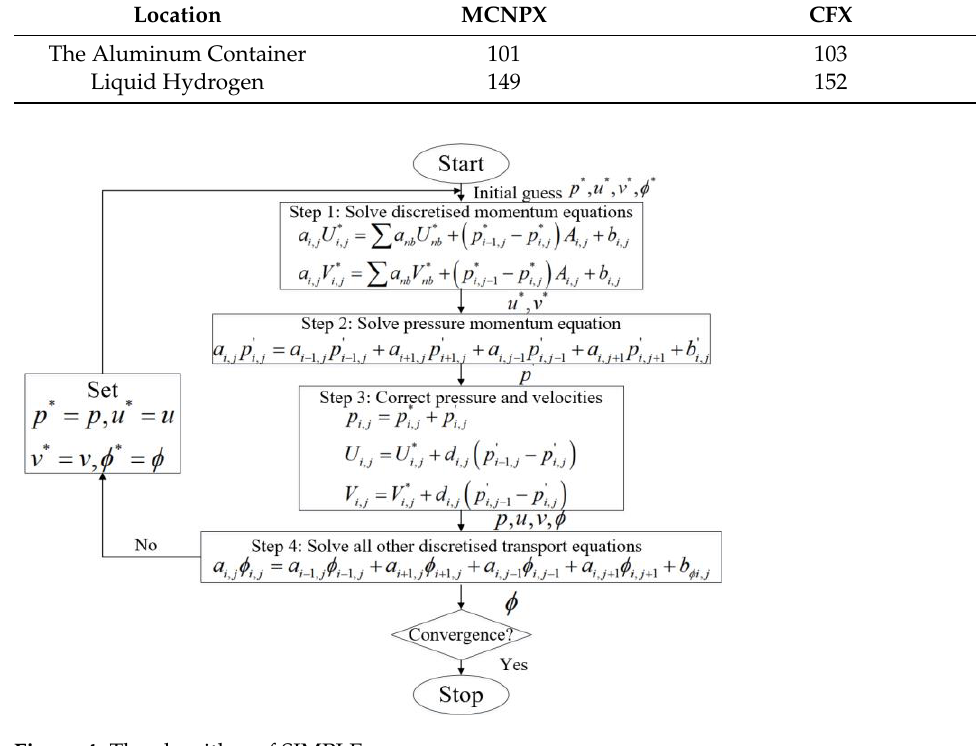
Figure 4. The algorithm of SIMPLE.